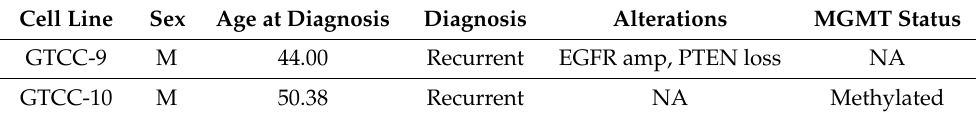
Table 1. Patient clinical